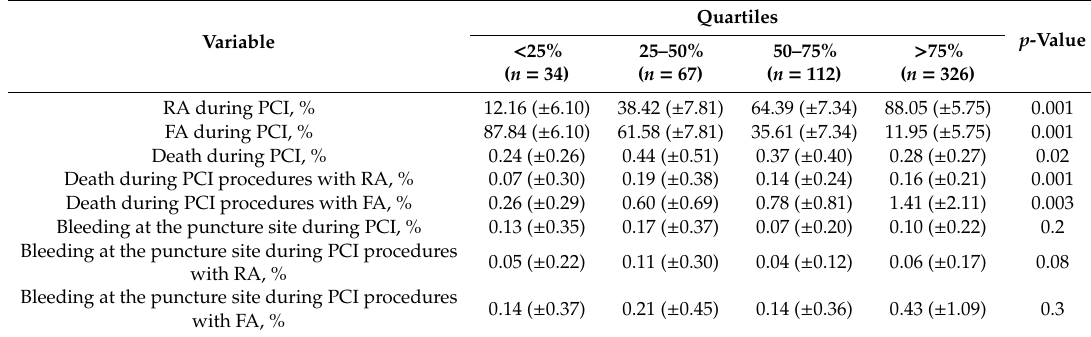
Table 4. Clinical outcomes of percutaneous coronary intervention performed by operators divided into quartiles depending on operator’s utilization of radial access site.